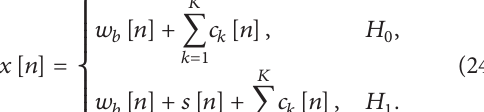
The other plot, which is significant, to visualize the performance of the detector is 𝑃 𝑑 versus SNR. The plot of 𝑃 𝑑 versus SNR at IMD of 2 dB at 𝑃 fa = 0.01 and observation interval 𝑁 = 15 is shown in Figure 5. Now, to analyze the effect of IMD, we plot the same graph keeping all the parameters constant and increase IMD to 10 dB; the plot obtained is shown in Figure 6. Comparing to the graphs plotted in Figures 5 and 6, it is concluded that when the IMD is low, the required 𝑃 𝑑 can be achieved at the low SNR. However, when IMD increases the same 𝑃 𝑑 is achieved at the high